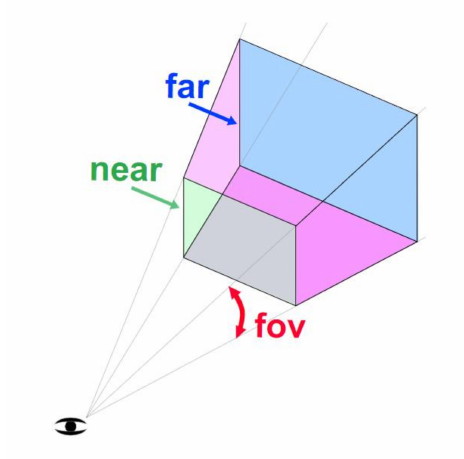
Figure 18. Diagram of a three.js scene.